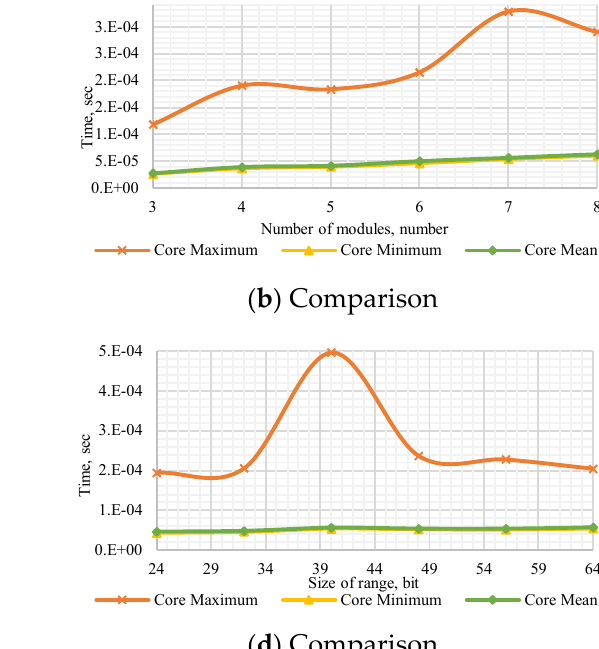
sign with a dynamic bit width, and ( d ) compare numbers with dynamic bit width.